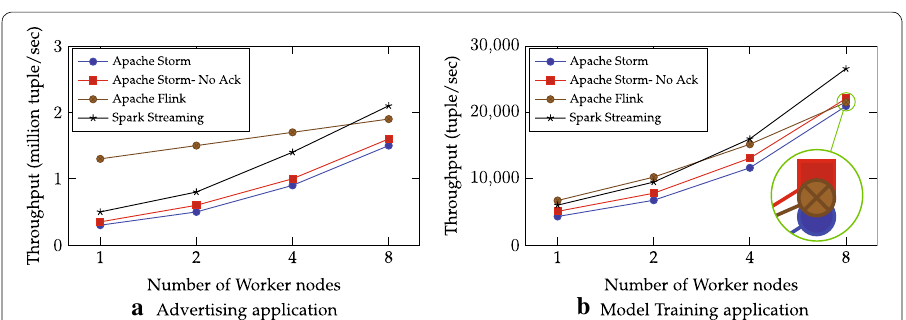
Fig. 18 Scalability comparison in terms of